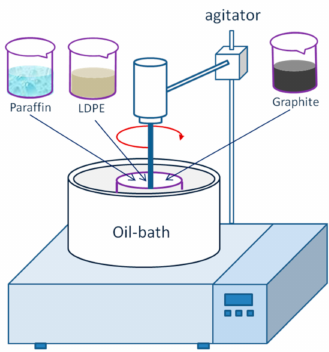
Figure 3. Schematic of shape-stabilized phase change material (SSPCM) preparation.